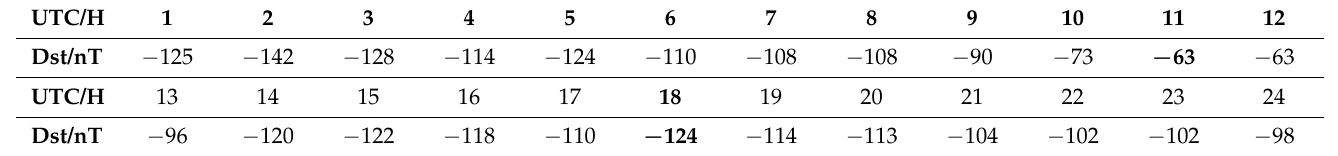
Table 3. The Dst index on 8 September